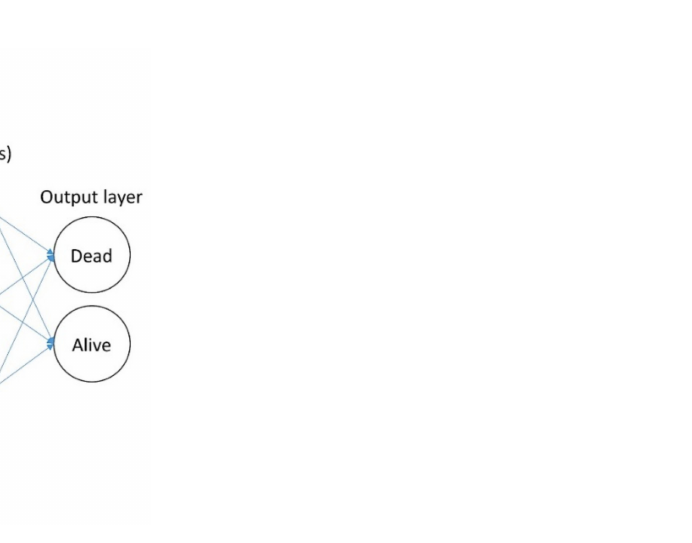
Figure 2. Basic structure of a multilayer perceptron (MLP). This figure shows the basic structure of an MLP artificial neural network, the same type of network used in this research. The network is characterized by a feedforward architecture with one hidden layer for predicting the overall survival outcome. The connections in the network flow forward from the input layer to the output layer without any feedback loop. The input layer contains the predictors (the gene expression data). The hidden layer contains unobservable nodes (units). The output layer contains the responses. The MLP network allows a second hidden layer. H (1:1) means hidden layer 1, node 1. In Table 1, the specific details of the neural networks are shown. For instance, the hidden layer of the MLP for overall survival had 6 nodes (H (1:1–6)), and that for the cell-of-origin molecular classification had 11 and 14 nodes.